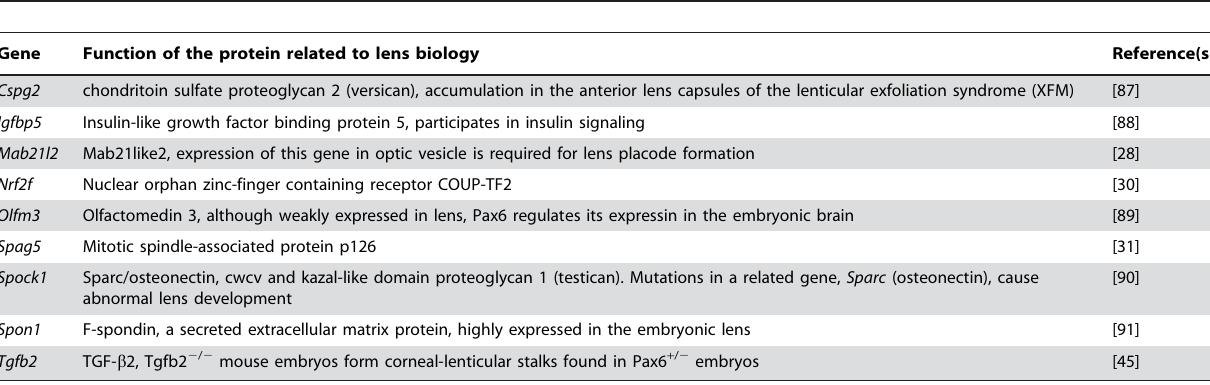
Table 1. A summary of genes regulated by Pax6 and studied as its candidate direct targets.